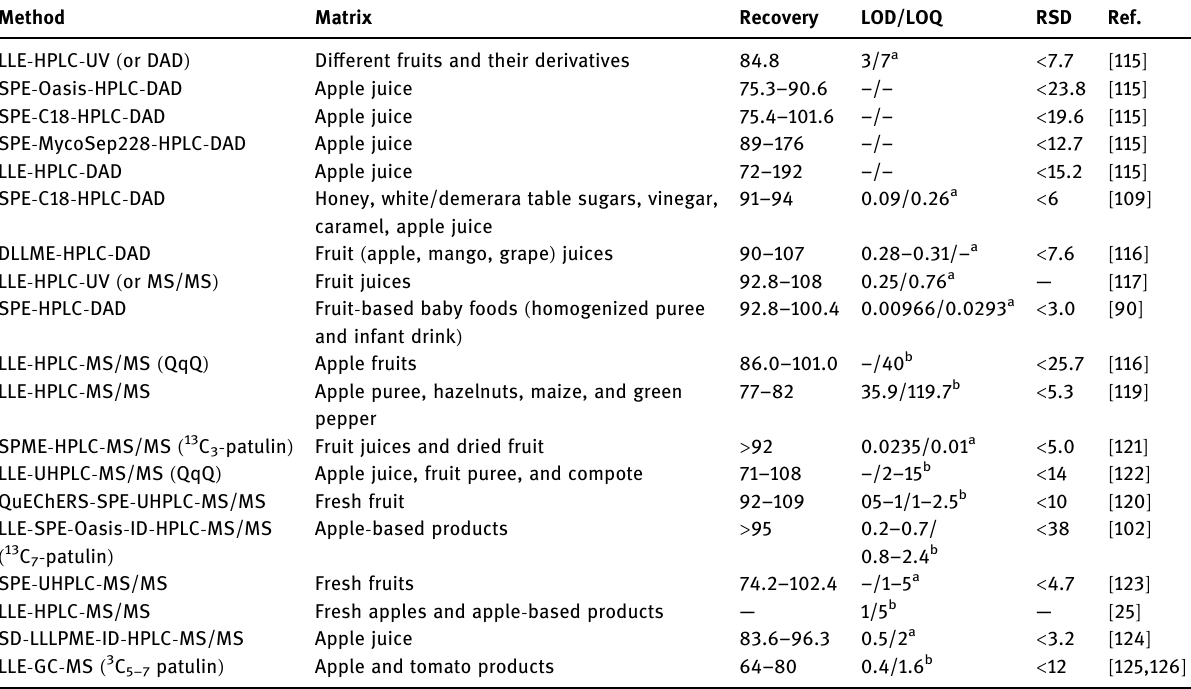
Table 5: Comparison of recovery ( % ) , LODs ( a: µg L − 1 ) , and LOQs ( b: µg kg − 1 ) and repeatability ( expressed as relative standard deviation, RSD,% ) of analytical methods for determining patulin in di ff erent matrices